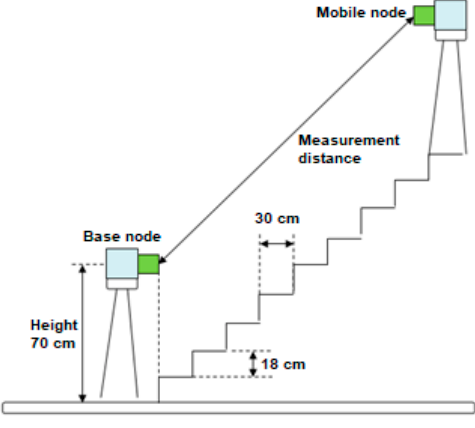
Figure 26. A vertical face-to-face measurement setup.